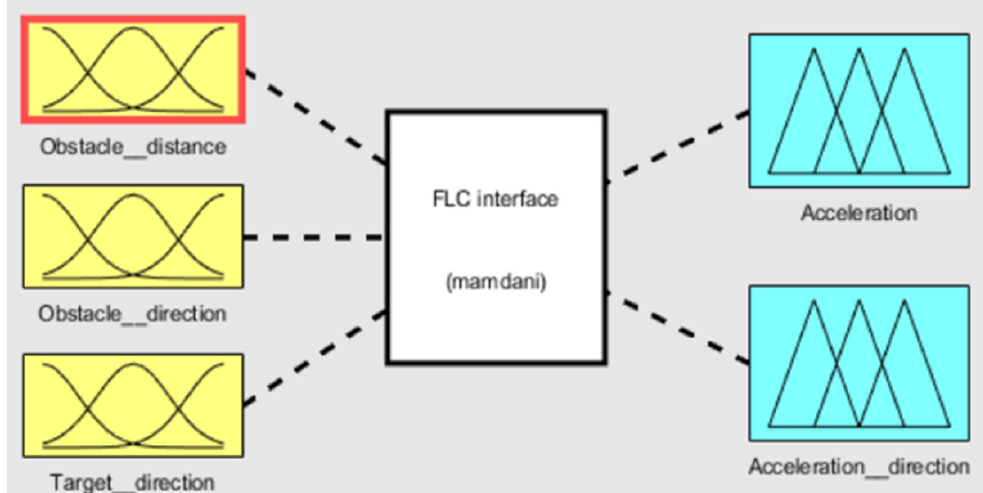
Figure 4. Fuzzy interface with three inputs and two outputs.